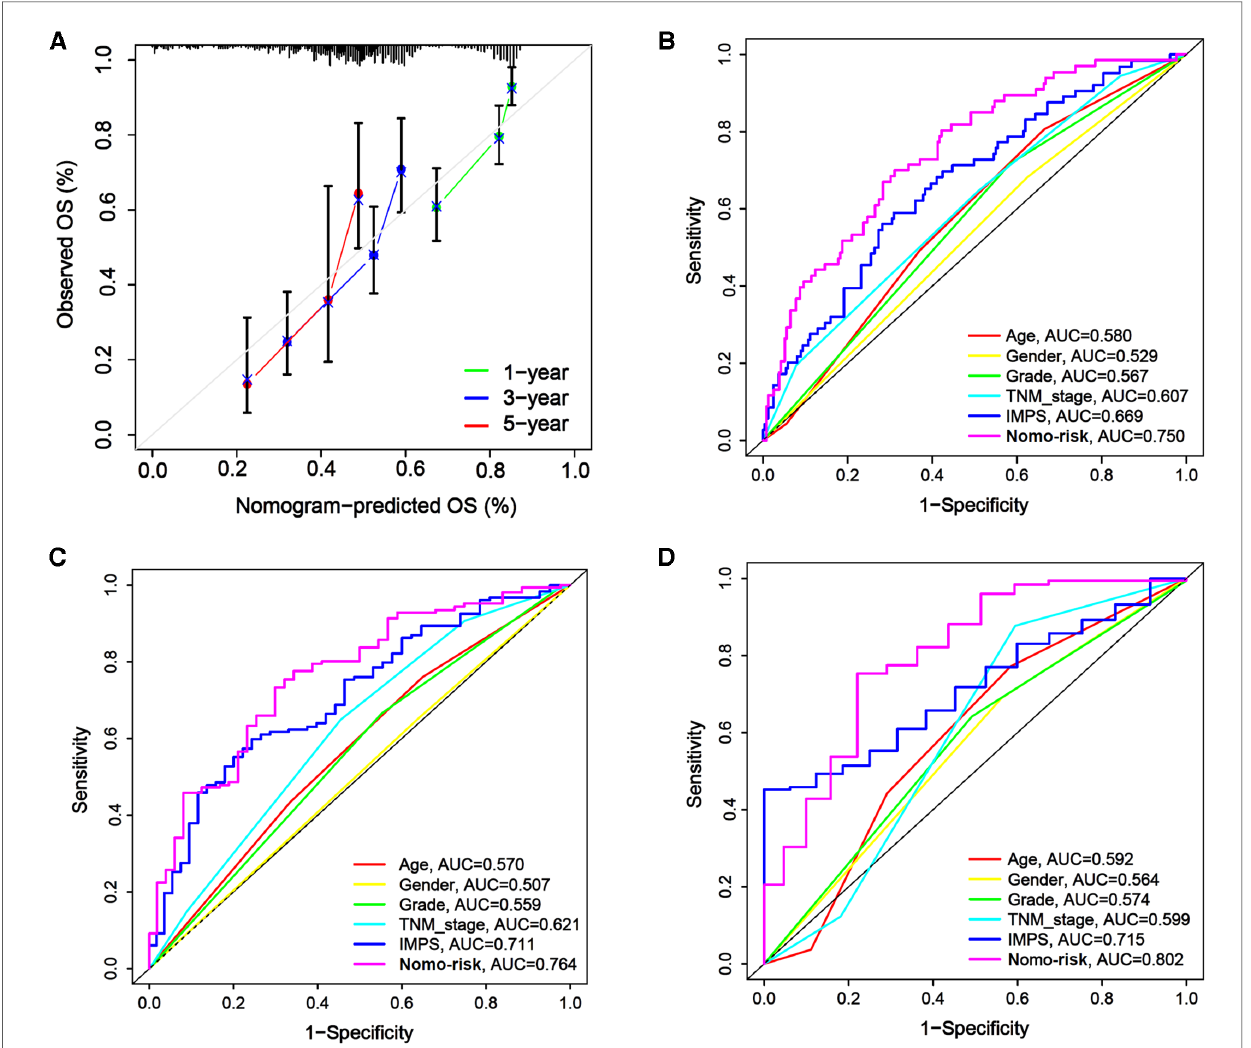
FIGURE 9 Calibration curves and time-ROC curve of the combined nomogram. ( A ) The combined nomogram calibration curves for 1-year, 2-year, and 3-year consistency between the predicted and observed OS. The actual performance of our combined nomogram is shown as the blue line. ( B – D ) The time-ROC curves of the combined nomogram risk, IMPS, TNM stage, grade, age, and gender in predicting OS at 1 ( B ), 3 ( C ), and 5 ( D )